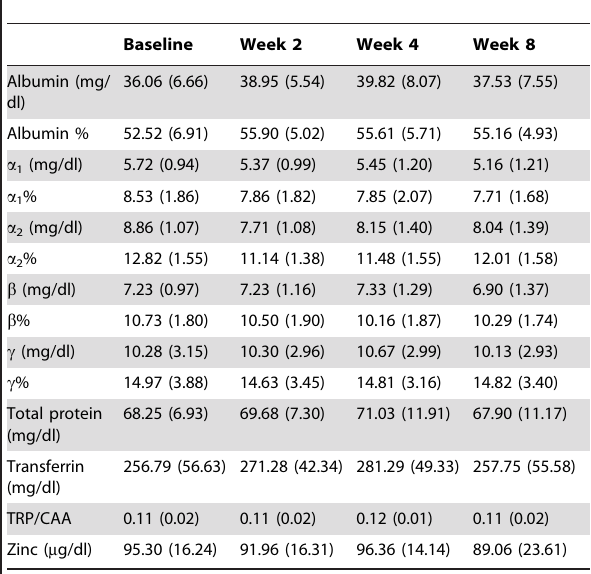
Table 2. Immune parameters and TRP/CAA at each time